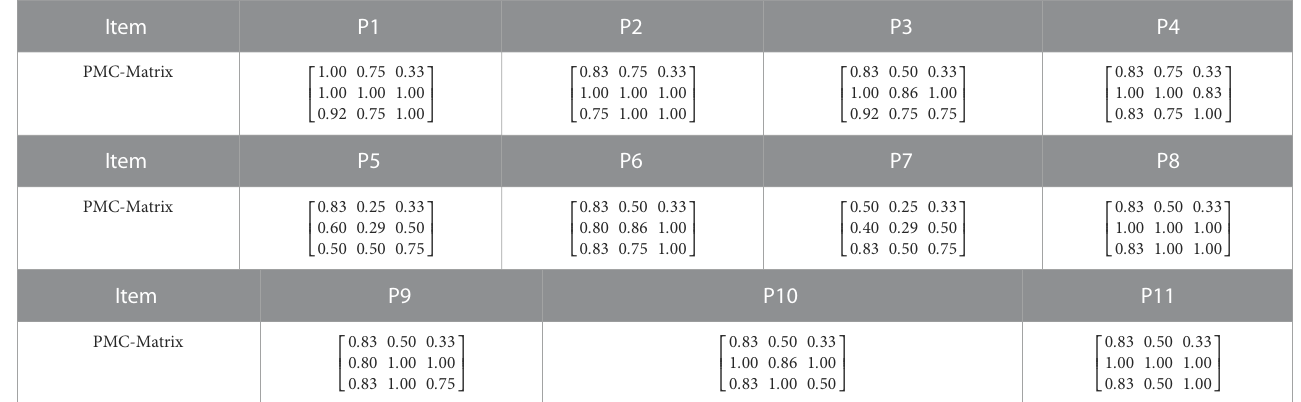
TABLE 7 The PMC-Matrix of 11